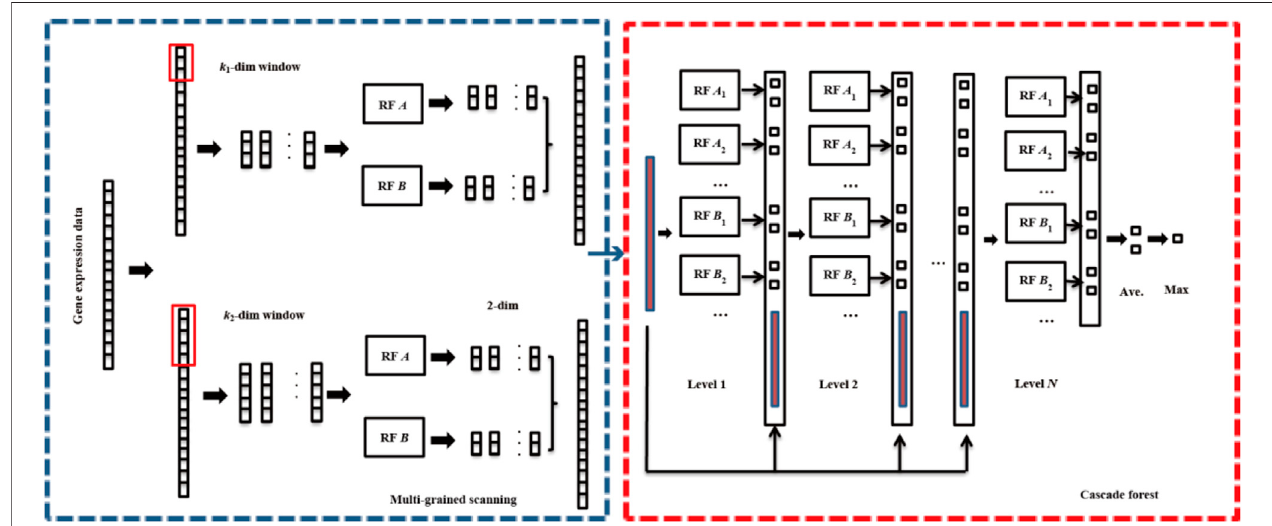
FIGURE 1 | The process of